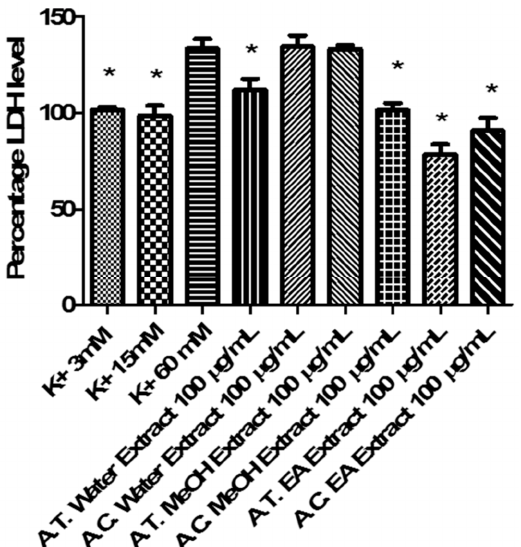
Figure 6. Effect of A. tinctoria (A. T.) and A. cretica (A. C.) extracts (100 µg/mL) on lactate dehydrogenase (LDH) level, measured on isolated rat cortex challenged with basal (K + 3mM) and depolarizing stimuli (K + 15 mM; K + 60 mM). Data are means ± SD of three experiments performed in triplicate. ANOVA, p < 0.0001; post-hoc, * p <0.05 vs. K + 60 mM control group.